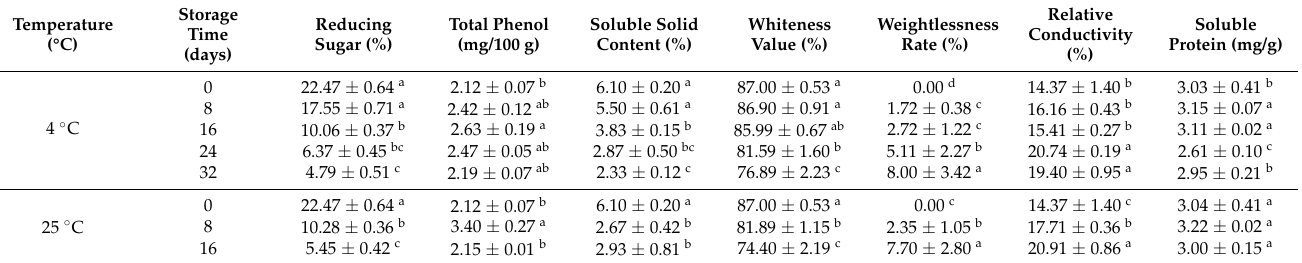
Table 1. Changes in quality of Z. latifolia at different storage